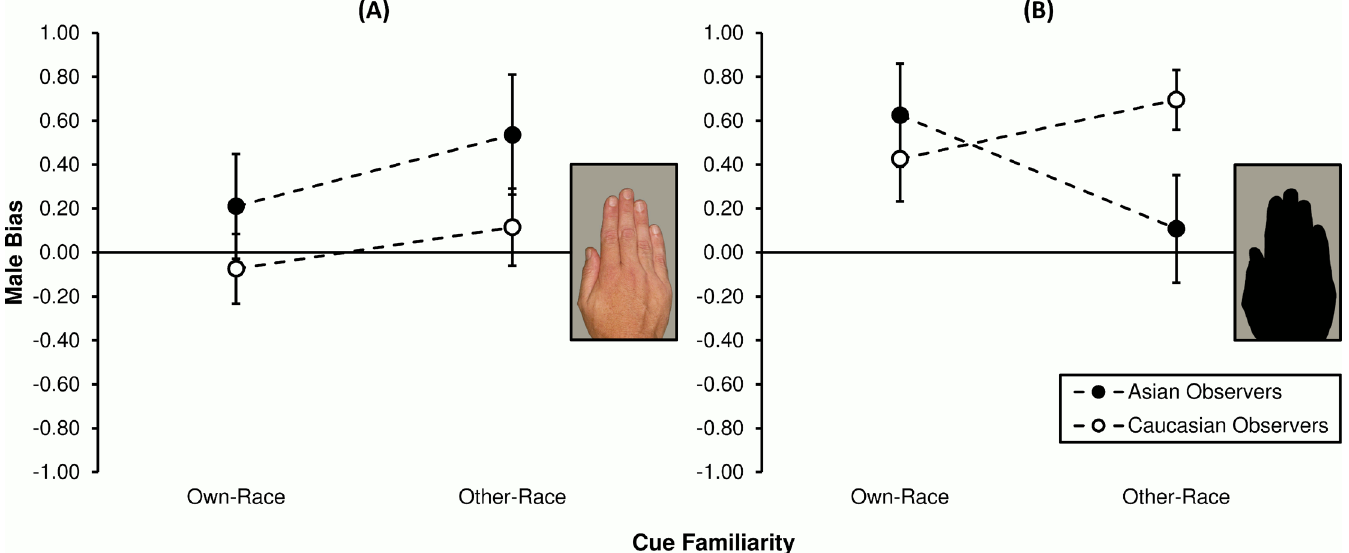
Fig 6. Sex classification bias for observers of hands each presented for 125 ms. Positive values represent, in standardised units, the mean tendency to report the presence of males and/or absence of females; negative values represent vice versa female bias ( c A = c female — c male ). Performance is grouped by observer race (Asians or Caucasians) and cue familiarity (own-race or other-race hands), plotted separately for the ( A ) intact and ( B ) degraded visual cue condition. Vertical bars represent ± 1 SEM